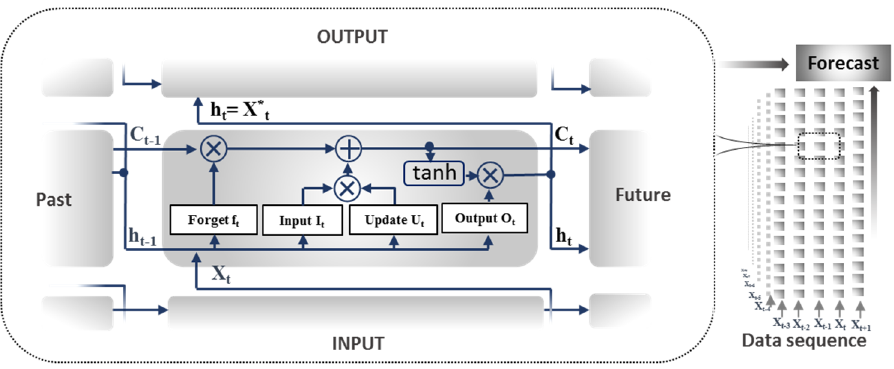
Figure 3. The main scheme of the hidden cell structure of the long short-term memory (LSTM) network.